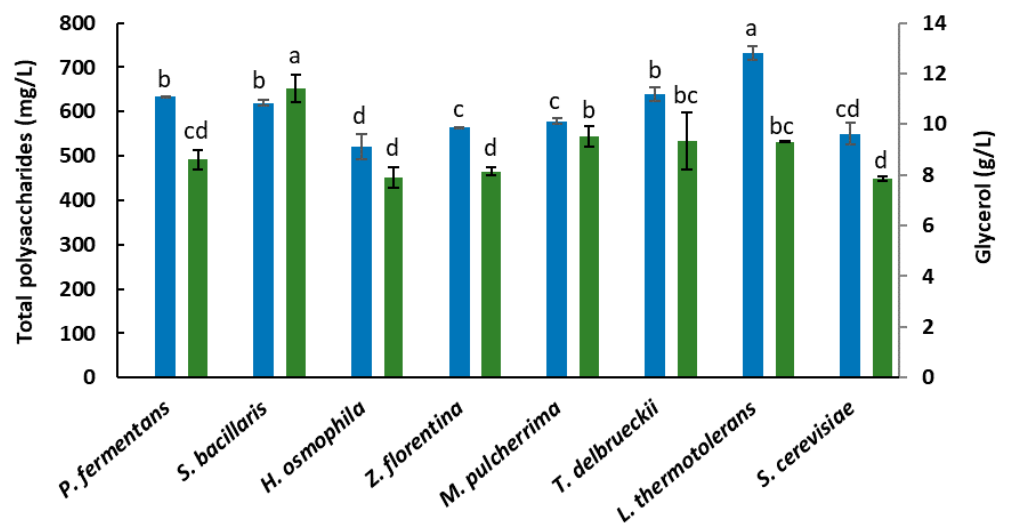
Figure 3. Total polysaccharides ( ■ ) and glycerol ( ■ ) in wines obtained four months after bottling. Data are means ±SD ( n = 2). Values displaying different letters (a, b, c, d) are significantly different according to the Duncan test ( p ≤ 0.05).